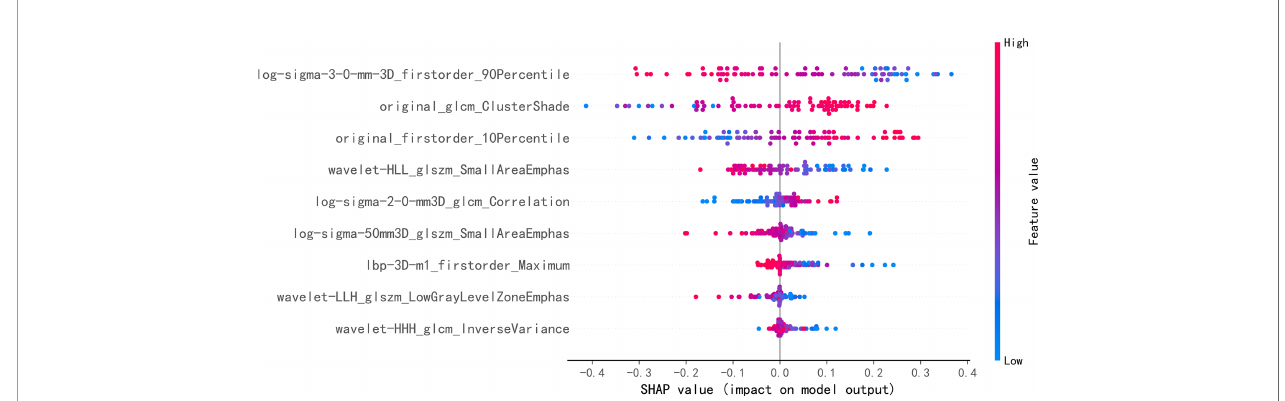
FIGURE 5 | Each point on the graph is a SHapley Additive exPlanations (SHAP) value for a feature and sample. The position on the y -axis is determined by the feature, and the position on the x -axis is determined by the SHAP value. In this graph, log-sigma-3-0-mm-3D_ fi rstorder_90Percentile, as the most important feature, has a high SHAP value. The color represents the value of the feature from low to high. Overlapping points jitter along the y -axis, so we get the distribution of SHAP values for each feature. The features are listed in order of their importance.